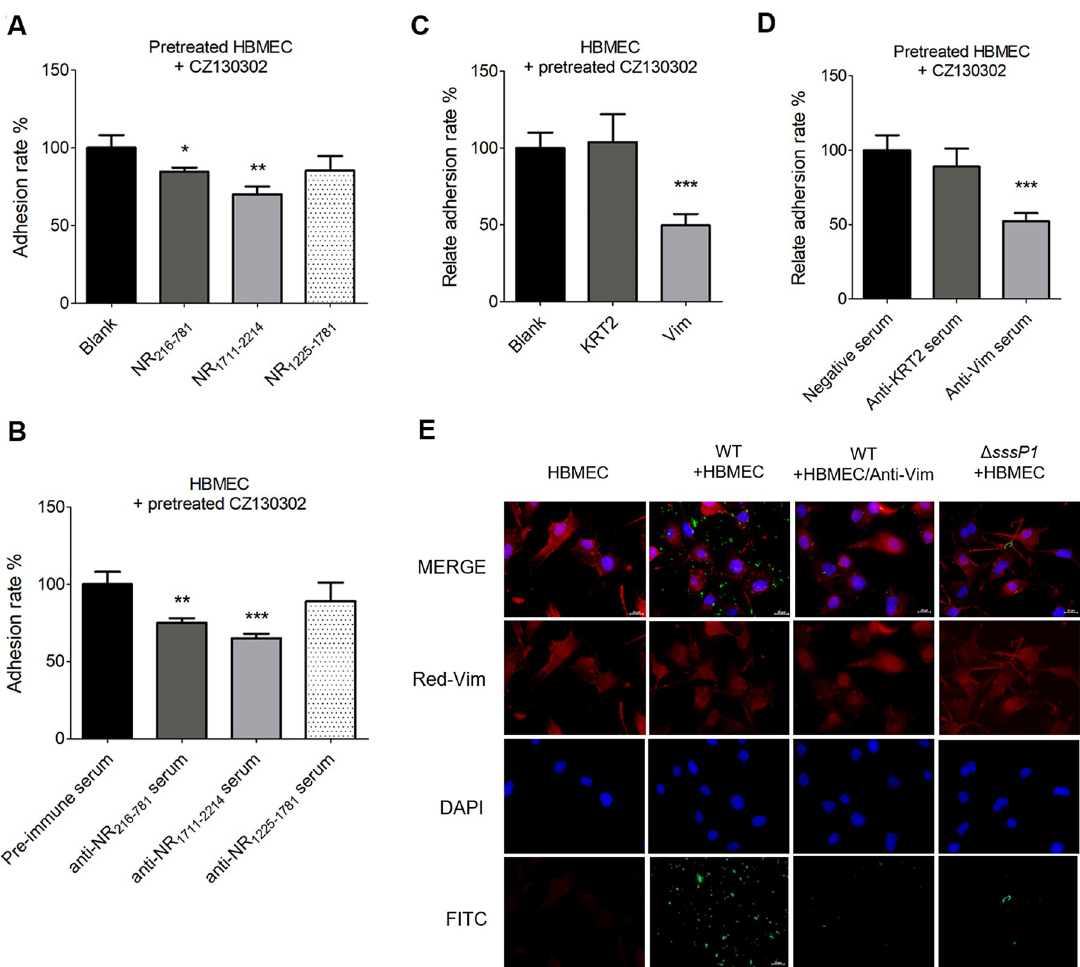
Fig 7. The adhesion of S . suis to HBMECs was attenuated by the blocking of vimentin, NR216-781 or NR1711-2214. All data are represented as mean ± SEM of triplicate samples ( ��� P < 0.001, �� P < 0.01, � P < 0.05). (A) The adhesion levels of S . suis strain CZ130302 were detected using the HBMECs pretreated with the NR 216-781 , NR 1711-2214 and NR 1225-1781 fragments. (B) The adhesion levels of S . suis strain CZ130302 to HBMECs were detected when anti-NR 216-781 or anti-NR 1711-2214 serums were added during co- incubation at MOI 100:1. The values were normalised against cells incubated with the pre-immune serum. (C) The adhesion levels of S . suis strain CZ130302 were detected using the HBMECs pretreated with the vimentin or Recombinant-keratin-2 (KRT2). KRT2 protein was use as the negative control. The cells without any treatments were used as the blank control. (D) The adhesion levels of S . suis strain CZ130302 to HBMECs were detected when the anti-vimentin or negative serums were added during the co-incubation at the MOI 100:1. (E) Confocal microscopy observation of vimentin skeleton and bacterial tracer. The images showed that the nuclei were stained with DAPI in blue, the vimentin was stained by IIF in red, and the S . suis cells with green fluorescent plasmid pKSM410-rss29 were observed in